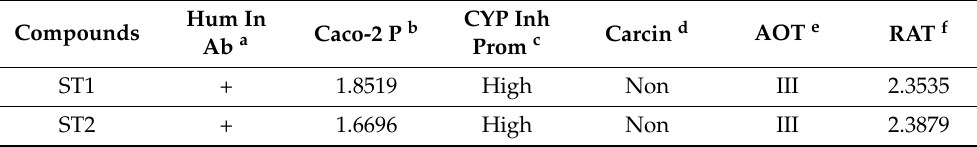
Table 4. ADMET profile calculations for ST1 – ST15